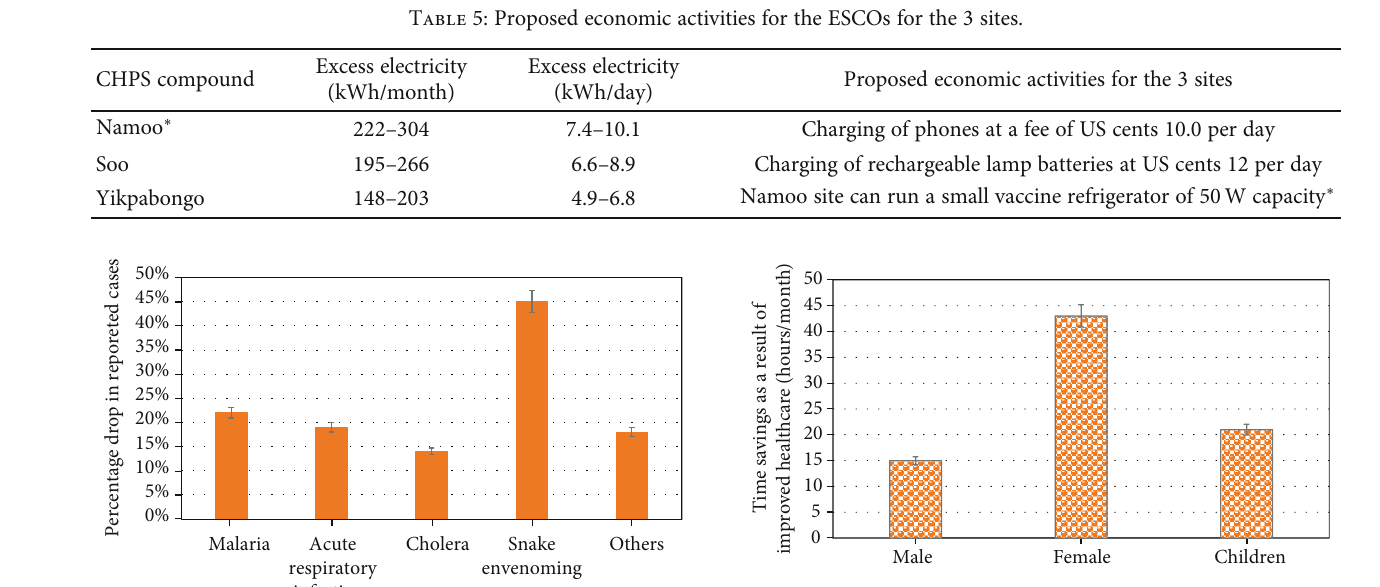
Figure 7: Monthly mean time savings in hours for di ff erent groups of